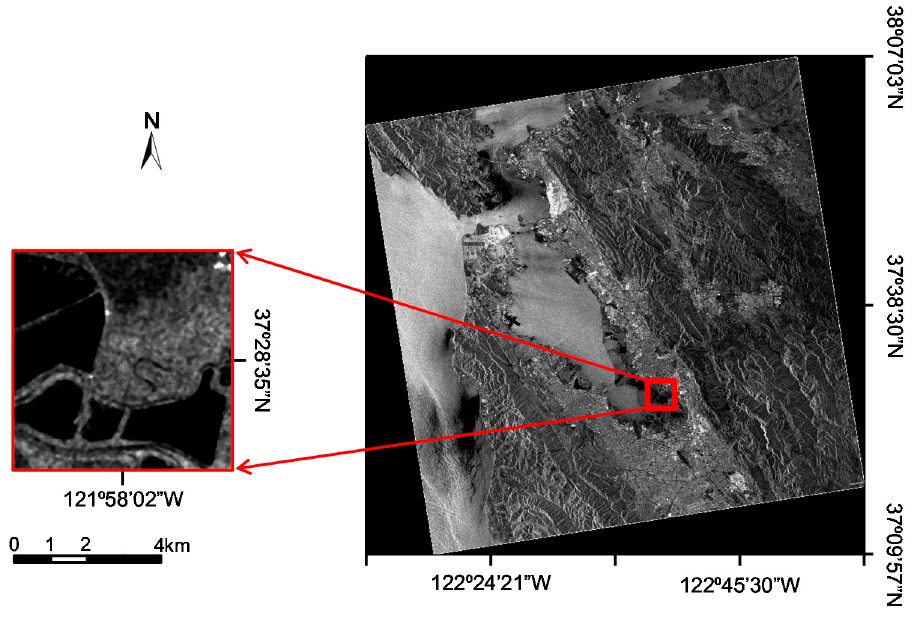
Figure 7. SAR images acquired by ERS-2 over the city of San Francisco.